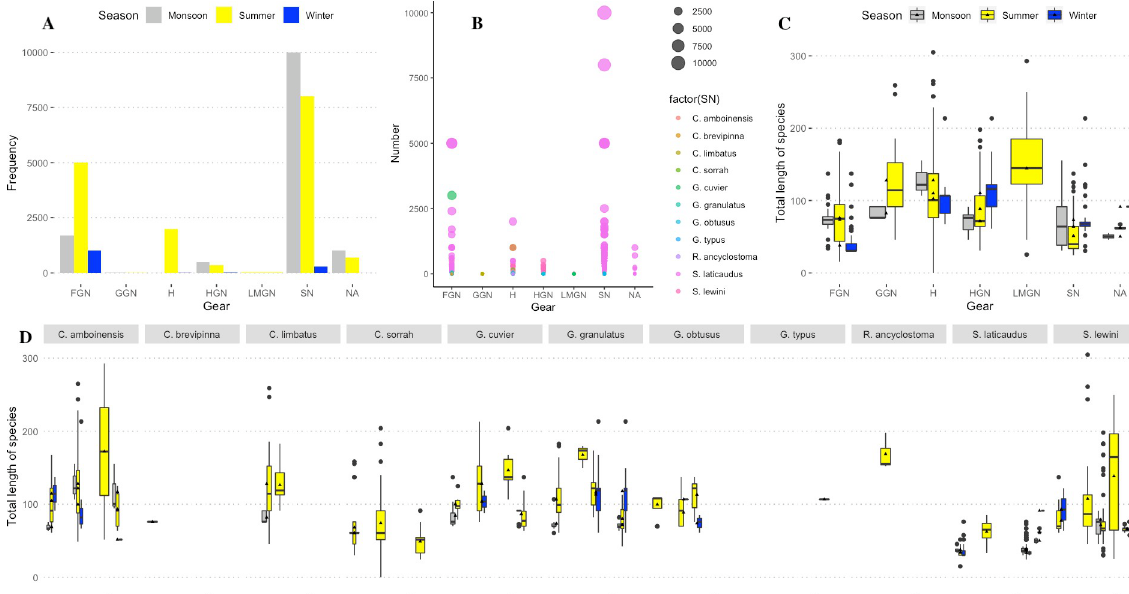
Fig 8. (A) Frequency of species caught in each documented gear type, (B) species-wise bulk landing in each gear type, (C) overall length- specific landing in each gear type, and (D) range of total length of different elasmobranch species and different gear used to catch the reported specimens (species-wise). Here, FGN = floating gillnet, GGN = general gillnet with varying mesh sizes, H = hooks, HGN = hilsa gill net, LMGN = large mesh gillnet (Lakkha jal), and SN = seine